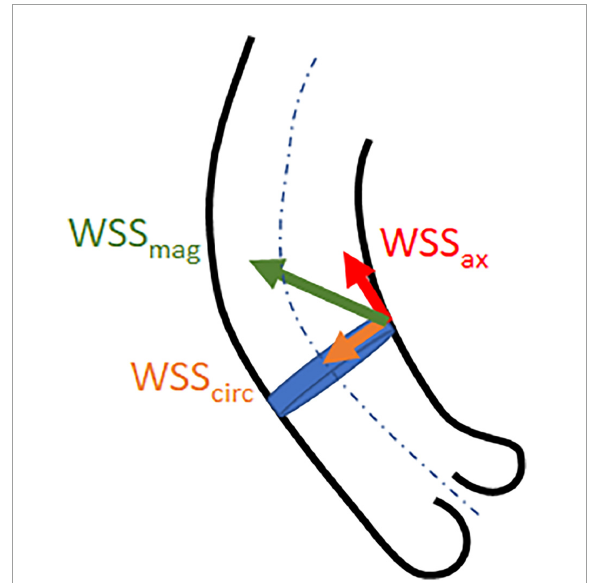
FIGURE1 Illustrative representation of wall shear stress net magnitude (WSS mag ) and the vector components axial (WSS ax ) and circumferential (WSS circ )